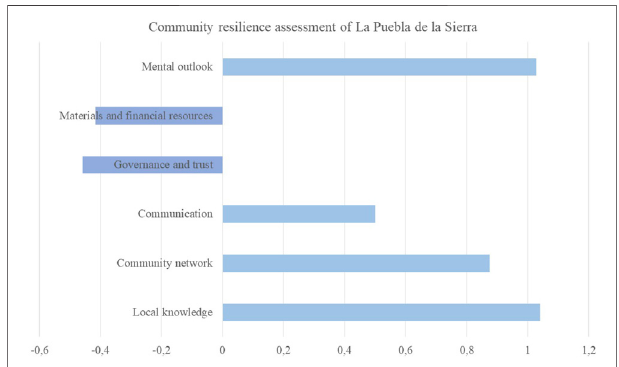
FIGURE 5 | Community resilience assessment of La Puebla de la Sierra (Verypositive=2;Positive=1;Neutral=0;Negative= − 1;Verynegative= − 2).